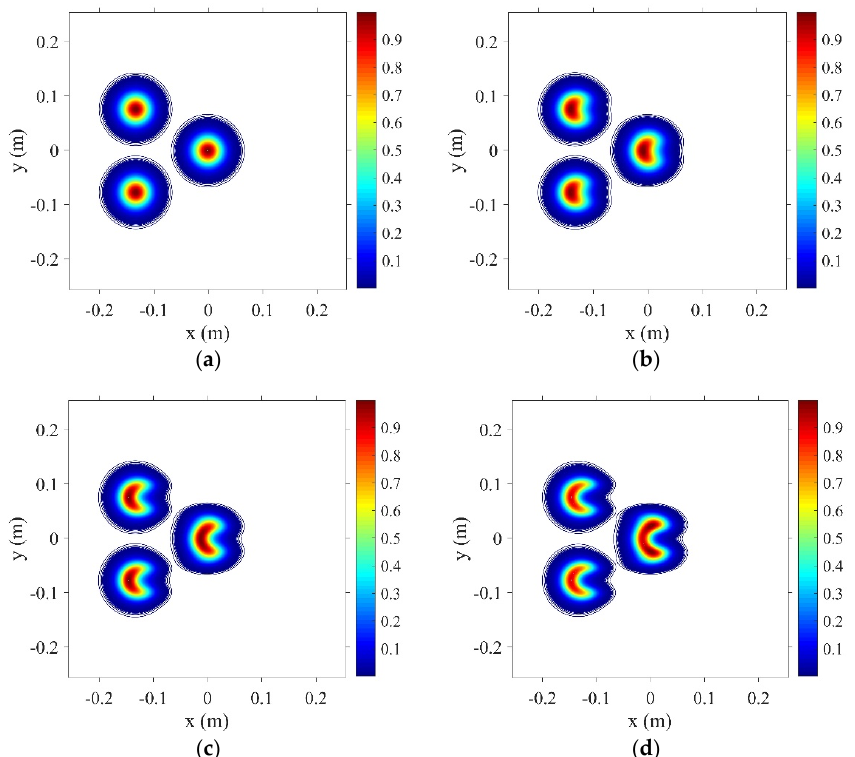
Figure 5. Thermal blooming of 3 − incoherent beams arranged as triangle where ( a ) Initial arrange ‐ ment; ( b ) N c = 0.5; ( c ) N c = 1.0 and ( d ) N c = 1.5. ment; ( b ) N c = 0.5; ( c ) N c = 1.0 and ( d ) N c =